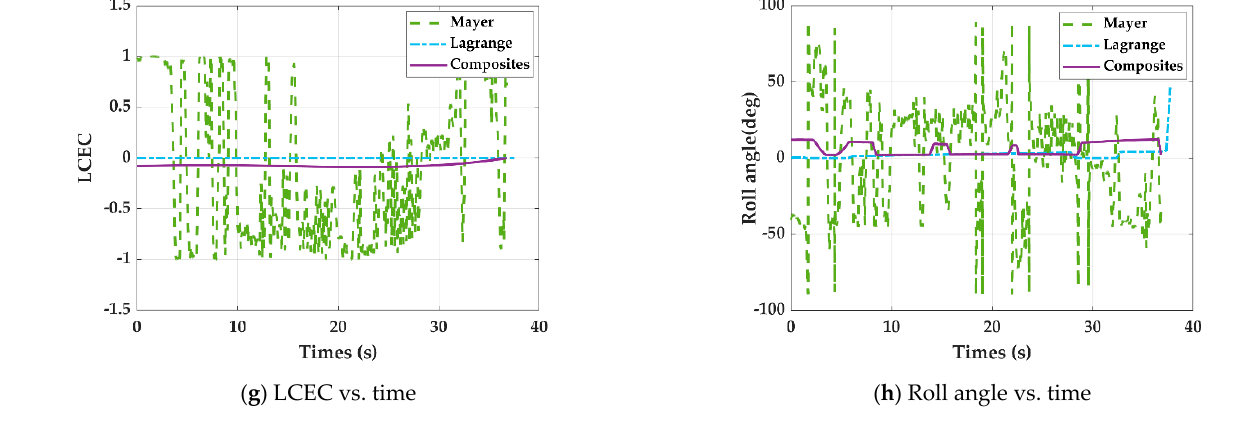
Figure 5. Trajectory optimization results. Table 5. Impact parameters with some constant CEC.